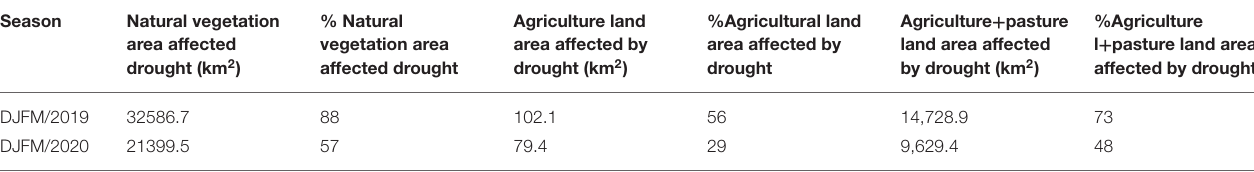
TABLE 1 | Areas of agriculture, natural vegetation and agriculture + pasture land (for livestock) affected by severe and exceptional